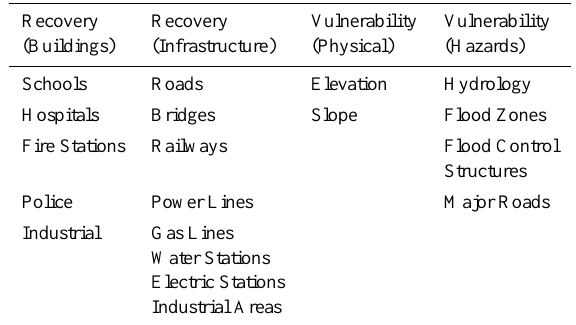
Table 1. Recovery and vulnerability elements included in 2012 en- hanced Austrian